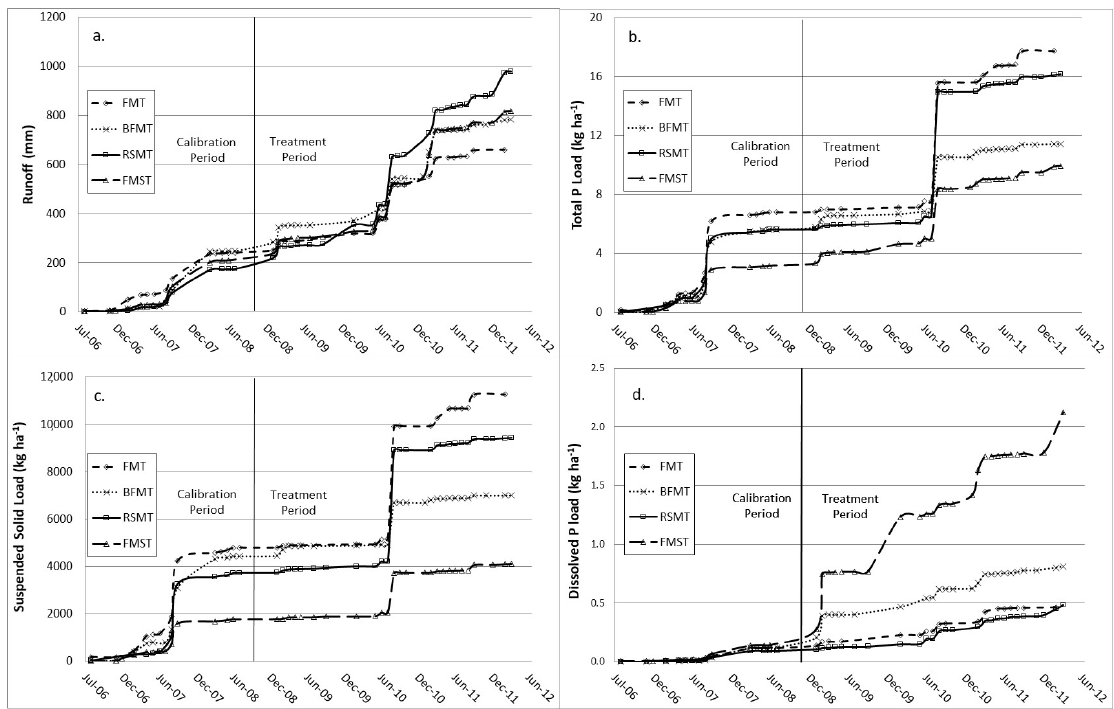
Figure 1. ( a ) Cumulative runoff (mm), ( b ) total P load (kg ha − 1 ), ( c ) suspended sediment load (kg ha − 1 ), and ( d ) dissolved P load (mg kg − 1 ) over the calibration (2006–2008) and treatment periods (2008–2012) for each watershed; FMT = fall applied manure with chisel tillage, RSMT = fall rye (cover crop) with spring-applied manure and chisel tillage; FMST = fall applied manure with spring tillage; BFMT = fall applied manure/chisel tillage with grass